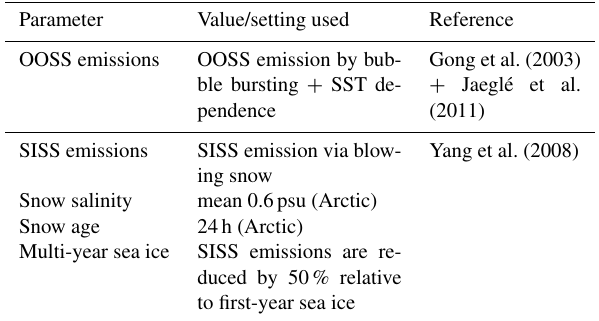
Table 1. Parameters chosen for p-TOMCAT base simulation 1991–